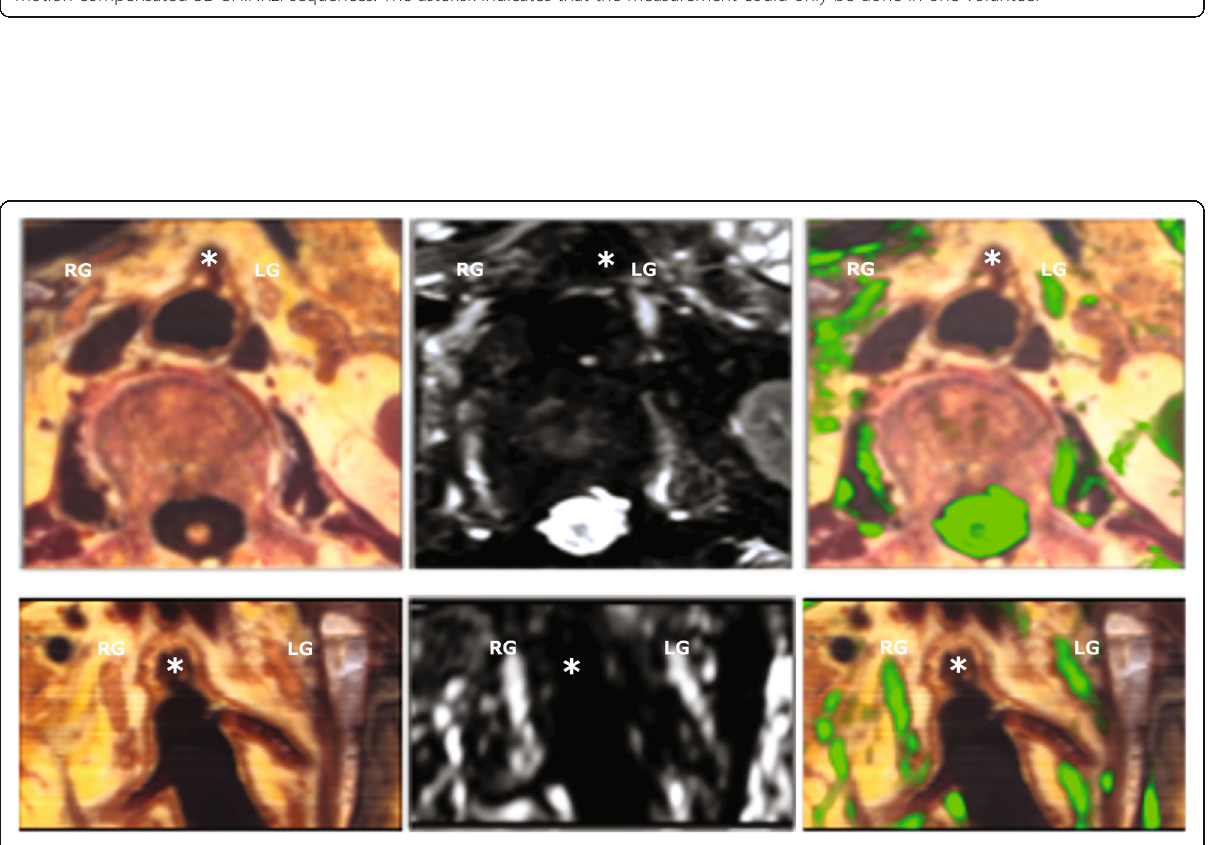
Fig. 3 Nerve-to-muscle signal ratio ( R nm ) at 3 T and 1.5 T for the 3D T2-weighted TSE, the respiratory-triggered 3D SHINKEI, and the double motion-compensated 3D SHINKEI sequences. The asterisk indicates that the measurement could only be done in one